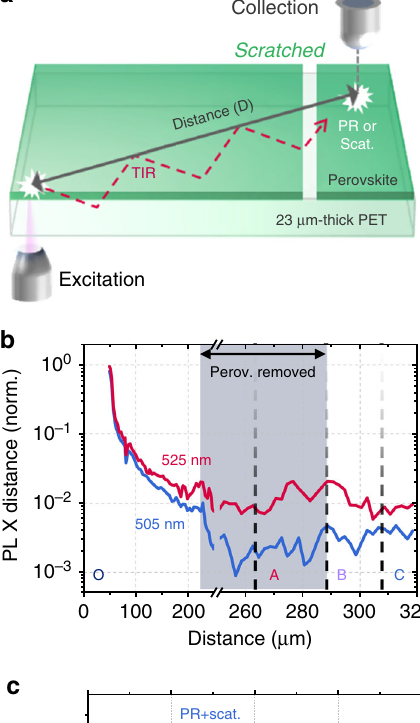
Fig. 2 Laterally measured PL and EL of perovskite. a Schematic representation of spatially resolved PL measurements with separate microscope objectives for excitation and collection. Trapped photons become detectable by either PR or scattering. b Laterally measured PL (normalised) as a function of distance from the point-of-excitation at wavelengths of 505 (± 5) nm and 525 (± 5) nm for a 2D – 3D